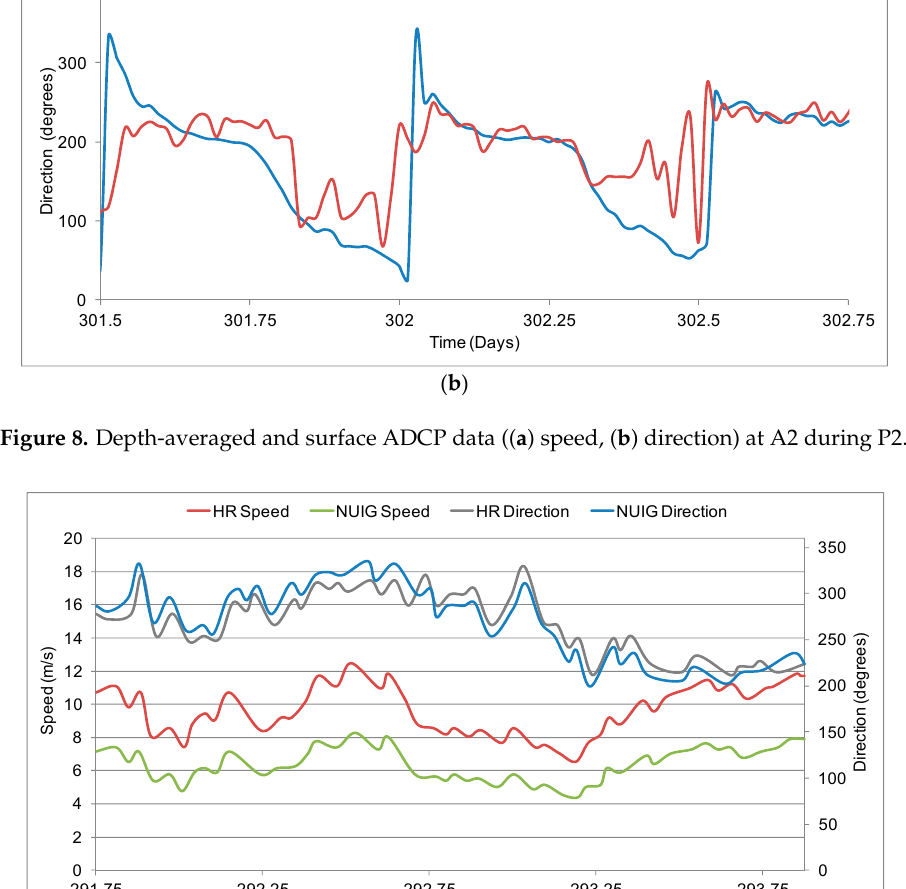
Figure 9. Time series of HR wind at A2 against NUIG wind during P1.